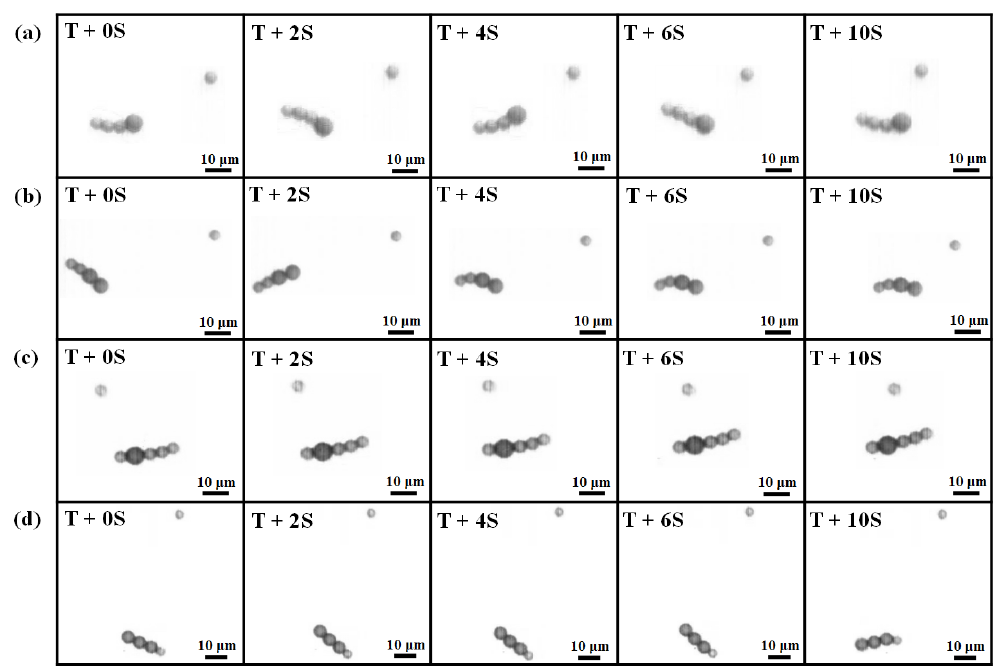
Figure 8. Sequential images of the ( a ) L1S3, ( b ) L2S2, ( c ) S1L1S3, ( d ) L3S1 swimmers in an oscillating field ( H p = 2000 A/m, H d = 1900, A/m, f = 10 Hz). T represents the time when the swimmer began swimming at the highest speed and then cruised at a constant speed, and S represents second. A static single particle was used as a reference point to observe the locomotion of the swimmer, as well as for evidence of the uniformity of the applied field.